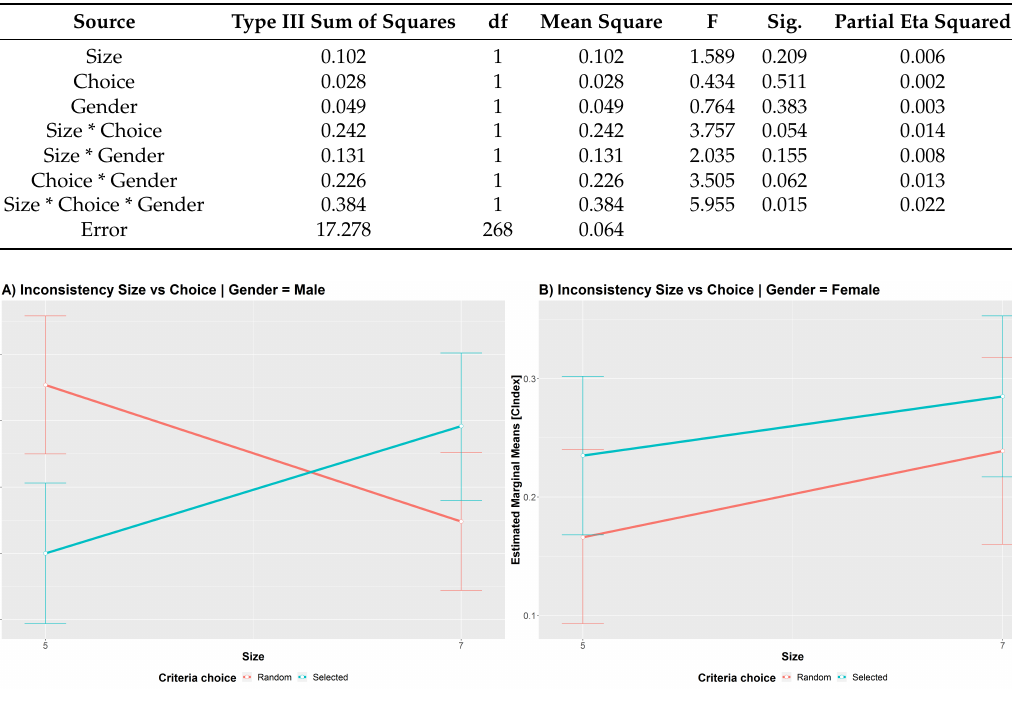
Figure 3. Estimated marginal means of inconsistency as measured by the CIndex coefficient. The figure shows different interactions of size and choice of criteria depending on gender. The error bars represent 95% confidence